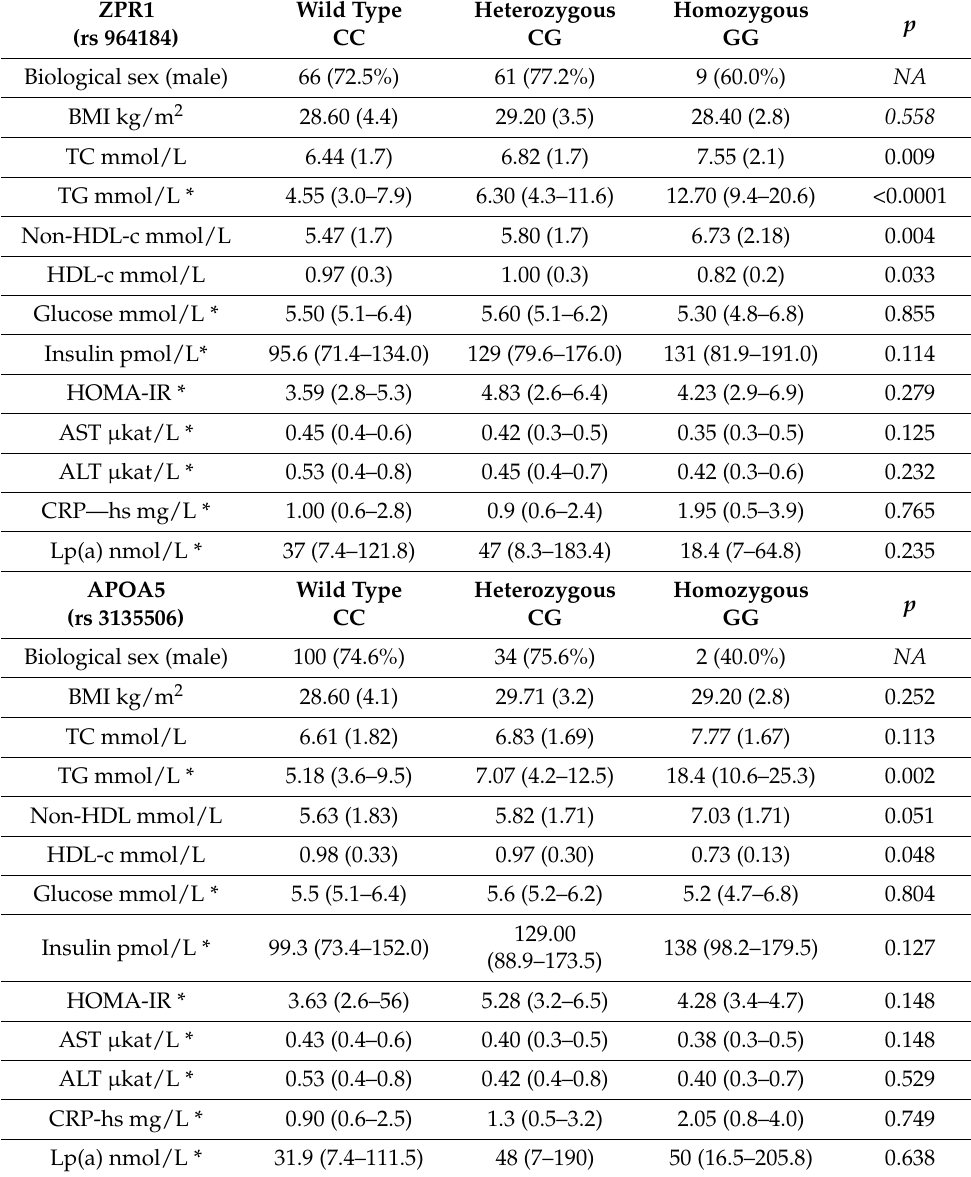
Table 4. Relationship between the genotype and metabolic traits of the ZPR1 (rs 964184) and APOA5 (rs 3135506)